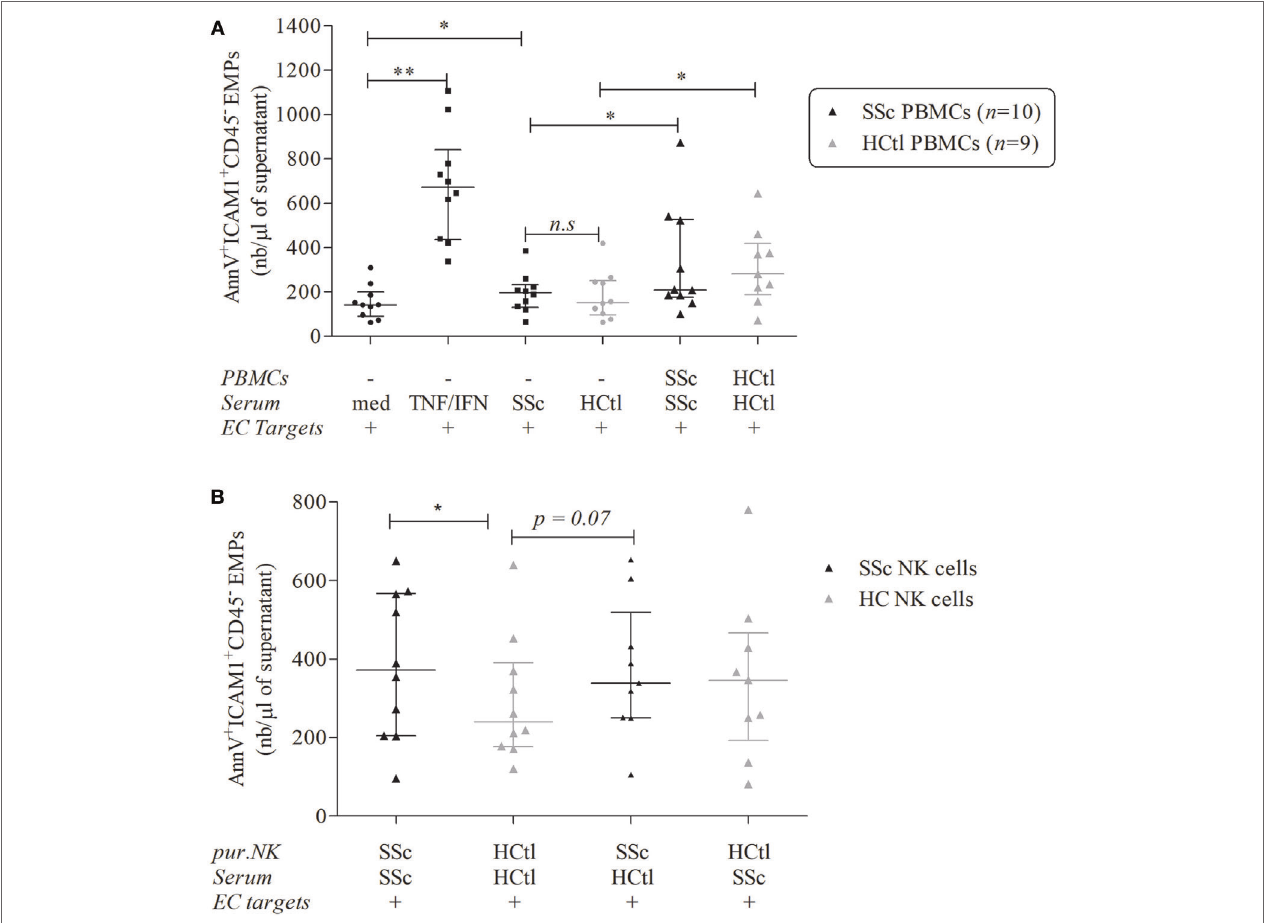
FigUre 7 | Endothelial microparticles (EMPs) release from microvascular endothelial cells (ECs) induced by natural killer (NK) cells from systemic sclerosis (SSc) patients. EMPs were obtained from the supernatant of overnight-cultured human microvascular dermal EC (HMVEC-d) line. (a) HMVEC-d were used as ECs targets and cultured with medium (med), i.e., EBM2 + 25% FCS ± IFN γ (50 ng/ml)/TNF α (20 ng/ml) or serum of SSc patients or healthy controls (HCtl) ± their autologous peripheral blood mononuclear cells (PBMCs) ( n = 10 and n = 9, respectively) with a PBMCs/HMVEC-d target ratio of 1/1. (b) HMVEC-d were cultured with EBM2 medium with serum from SSc patients or healthy controls and purified NK cells (pur. NK) from SSc patients ( n = 10) or healthy controls ( n = 9–10) with a NK cells/ HMVEC-d ratio of 2/1. Results were expressed as median number of EMPs per microliter ± interquartile range. Cumulative data from 10 independent experiments. Statistical significance was established using the non-parametric paired Wilcoxon U -test. * p < 0.05, ** p <